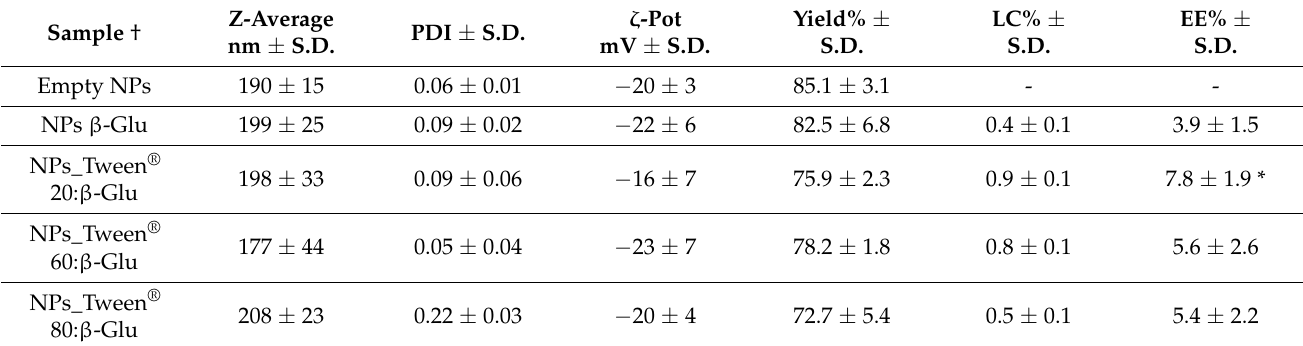
Table 2. Effect of Tween ® Type Comparison on Nanoparticle Characteristics.